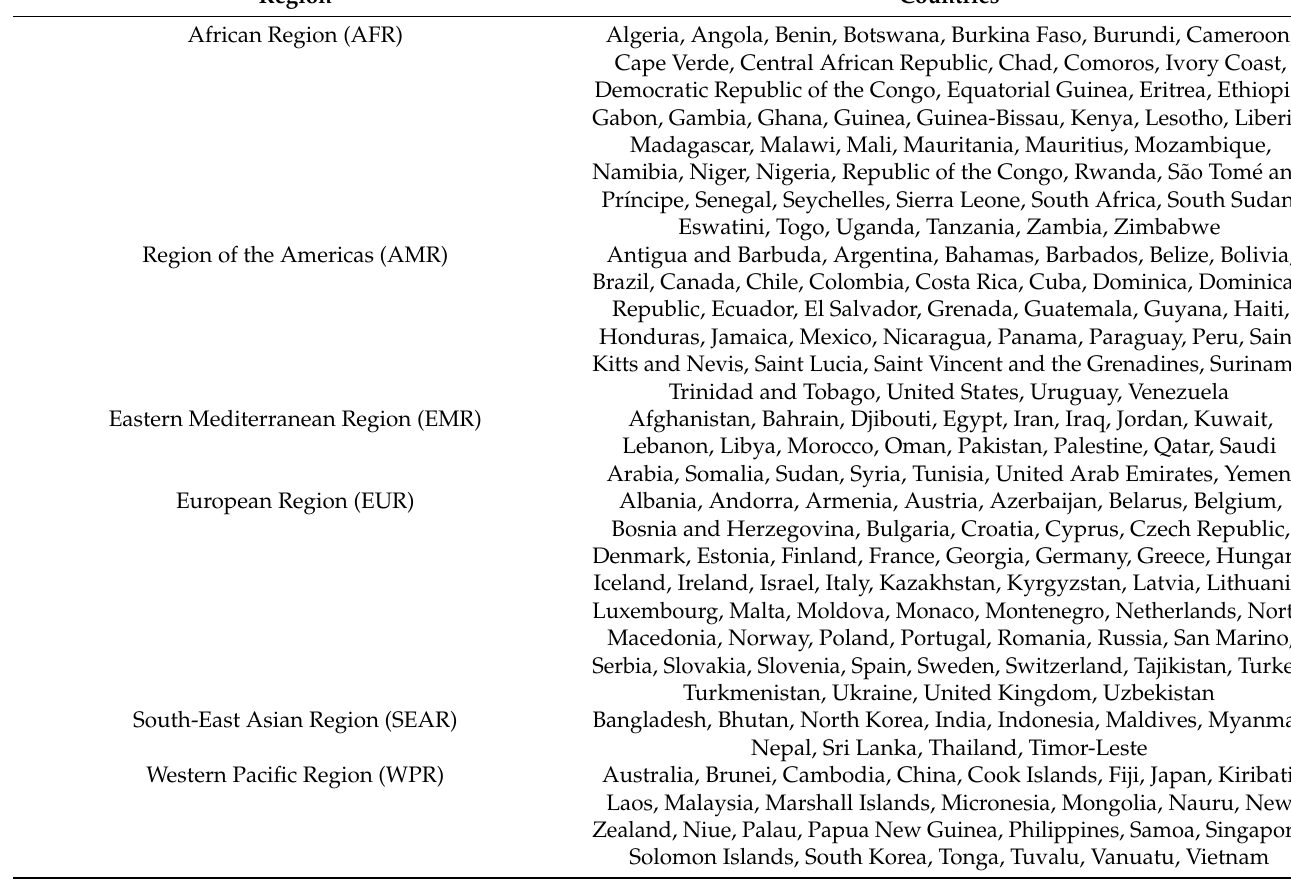
Table 1. List of WHO